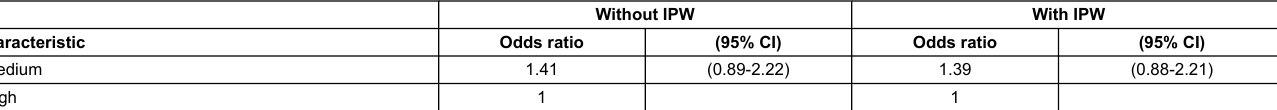
Table S6: Estimated independent associations of smoking cessation between SAPALDIA1 (1991) and SAPALDIA2 (2002) with different personal characteristics assessed at SAPALDIA1, by gender.